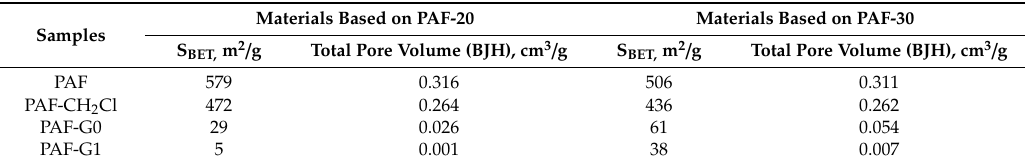
Figure 1. Solid-state 13C cross polarization-magic angle spinning nuclear magnetic resonance (CP-MAS NMR) spectra of obtained materials. Table 1. Results of low-temperature nitrogen adsorption-desorption for obtained